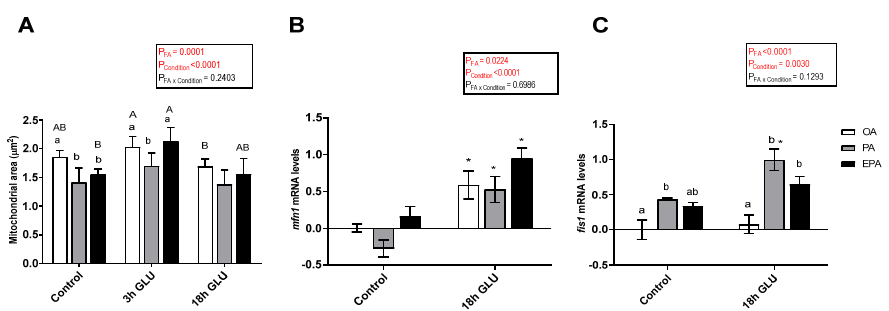
Figure 8. ( A ) Mitochondria area from immunostaining images in mature Atlantic salmon adipocytes incubated with oleic, palmitic, or eicosapentaenoic acid for 72 h (Control) and serum-deprived in the presence of glucagon thereafter for 3 (3 h GLU) and 18 h (18h GLU). Data are shown as mean ± SEM ( n = 4–6). Results are compared by two-way ANOVA using the fatty acid tested (OA, PA, and EPA) and the experimental condition (Control, 3 h GLU, and 18 h GLU) as factors. Lowercase letters indicate significant di ff erences between fatty acids and capital letters indicate significant di ff erences between conditions ( p < 0.05; Tukey’s post hoc test). ( B ) Relative changes in transcript levels of mfn1 and fis1 ( C ) in mature Atlantic salmon adipocytes incubated with oleic, palmitic, or eicosapentaenoic acid for 72 h (Control) and serum-deprived in the presence of glucagon thereafter for 18 h (18 h GLU). Samples ( n = 4) were analyzed with real-time qPCR; data are presented as − ∆∆ Ct ± SEM, and the OA group from the Control condition was set to zero. Results are compared by two-way ANOVA using the fatty acid tested (OA, PA, and EPA) and the experimental condition (Control and 18 h GLU) as factors. Lowercase letters indicate significant di ff erences between fatty acids ( p < 0.05; Tukey’s post hoc test). Asterisks (*) indicate significant di ff erences between conditions ( p < 0.05; Sidak’s test). OA = oleic acid, PA = palmitic acid, and EPA = eicosapentaenoic acid.